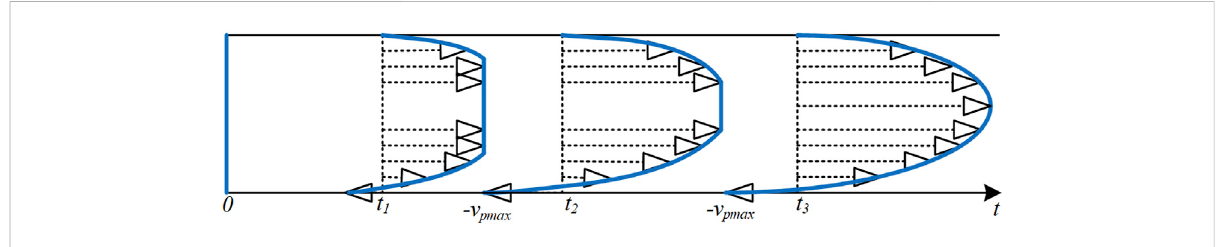
FIGURE 9 Dynamic development of the fl ow layer modeling for MREA.